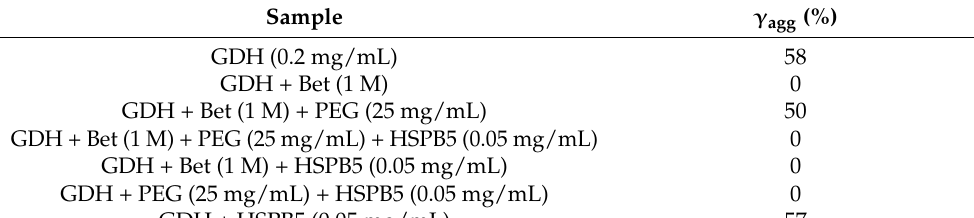
Table 1. Estimation of the fraction of aggregated protein ( γ agg ) precipitated during the acceleration of the rotor in the AUC experiments at 25 °C. Rotor speed was 48,000 rpm. Before the experiment, the samples were heated at 50 °C for 10 min and then cooled in ice.